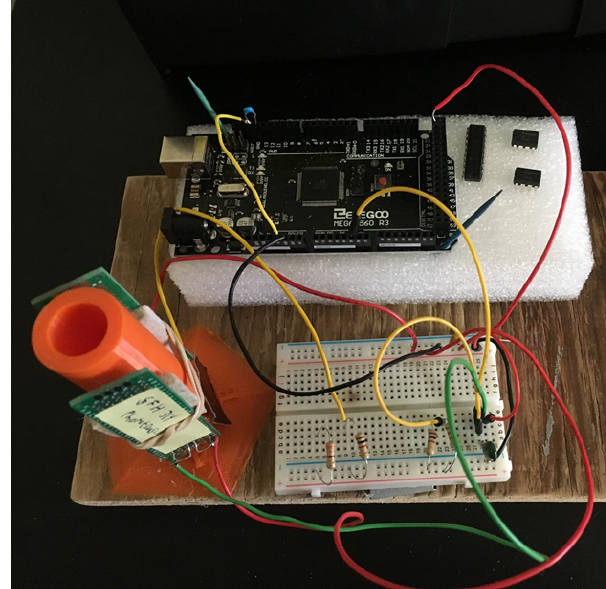
Figure 4. Circular sample holder and test circuit.